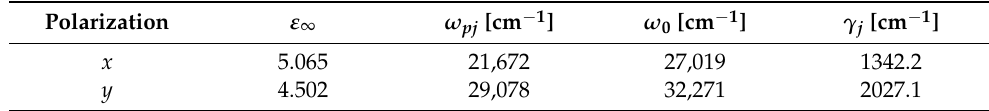
Figure 1. ( a ) The schematic diagram of the unit of proposed absorber, consisting of multilayer α -MoO 3 nanoribbons/SiO 2 stacked on a silver substrate. In this design, the optimized geometrical parameters are listed as follows: h = 100 nm, w 1 = 105 nm, w 2 = 275 nm, w 3 = 345 nm, p = 500 nm. ( b ) The layered orthorhombic α -MoO 3 structure, in which the yellow and red balls represent molybdenum and oxygen atoms, respectively. Real ( c ) and imaginary ( d ) parts of the refractive index of α -MoO 3 in the visible region. Table 1. Parameters used in Equation (1) to obtain the permittivity tensors of α -MoO 3 in the visible